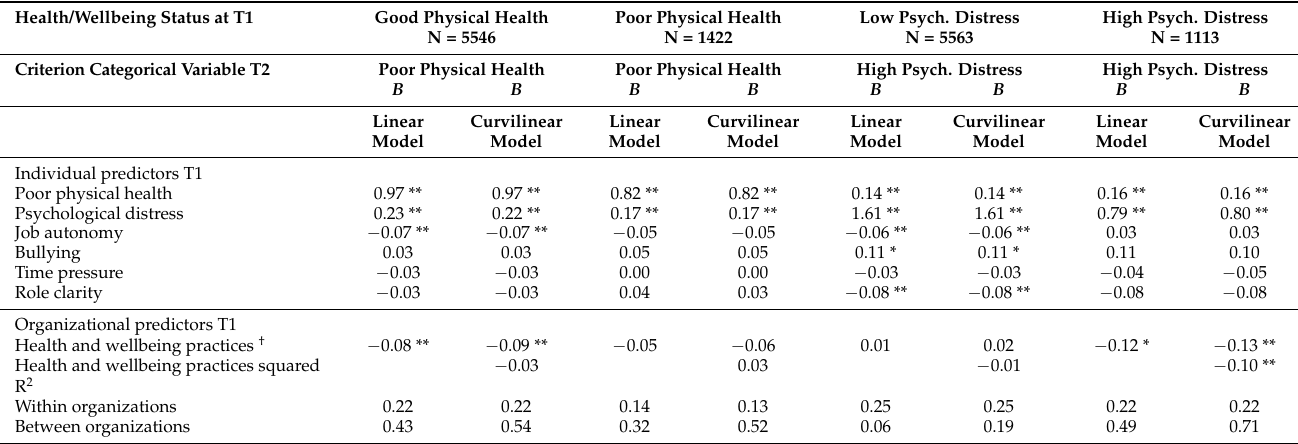
Table 4. Regression coefficients of multilevel probit linear and curvilinear regression analyses with Bayesian estimation. Health/Wellbeing Status at T1